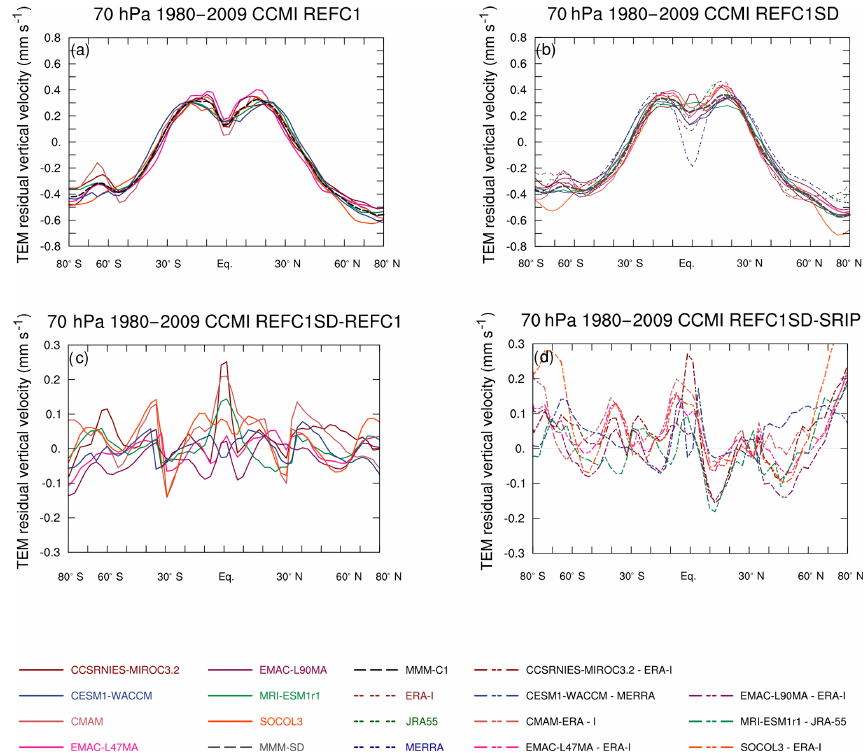
Figure 3. Mean strength of annual mean w ∗ (mms − 1 ) at 70hPa for (a) REF-C1 free-running models, (b) REF-C1SD nudged models, (c) absolute differences between the REF-C1SD and REF-C1 experiment for each model, and (d) absolute differences between each REF- C1SD simulation and the respective reanalysis used for